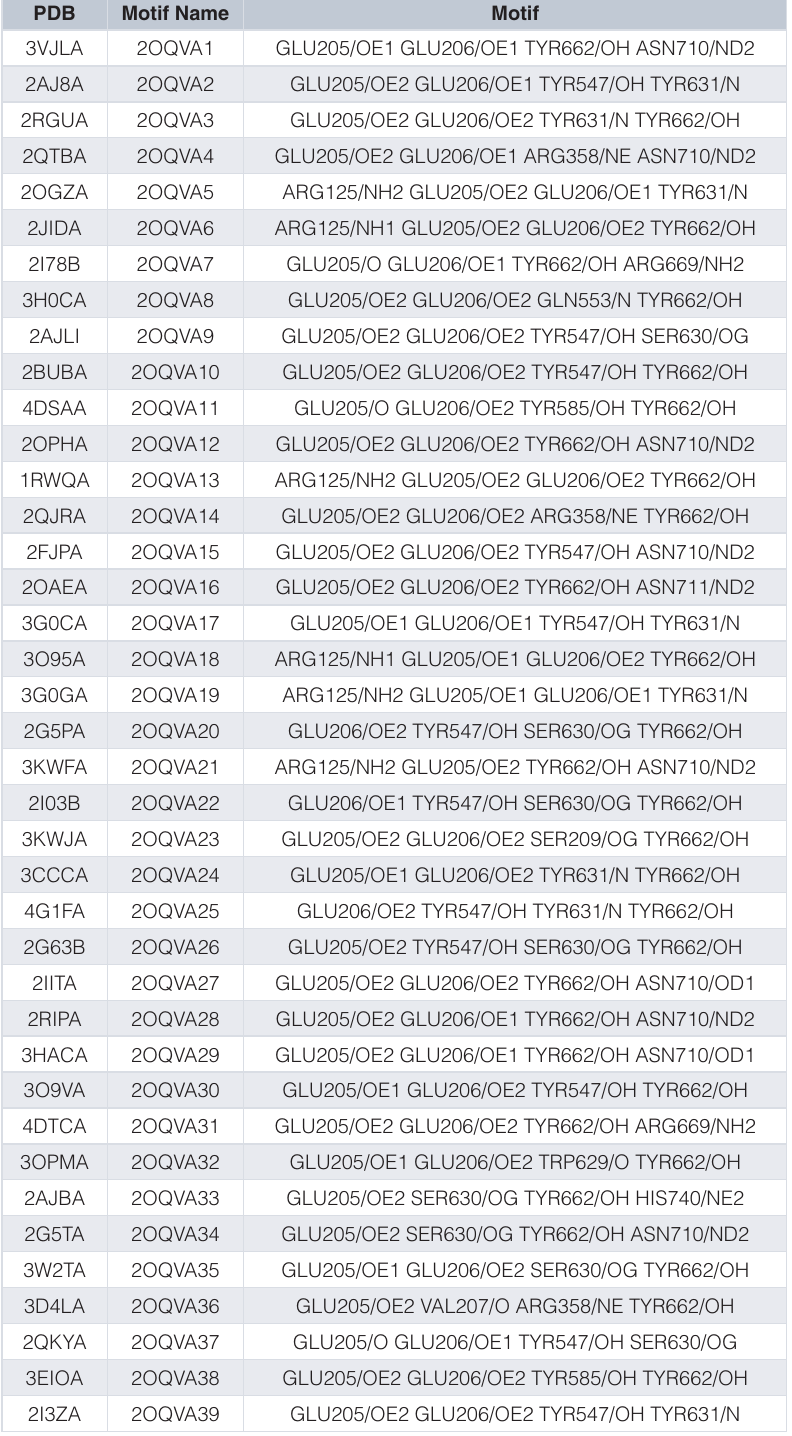
Supplementary Table 3. Library of non-redundant motifs. This library of motifs can be used to query any protein using CLASP to determine the possibility that DPP4 inhibitors might bind to